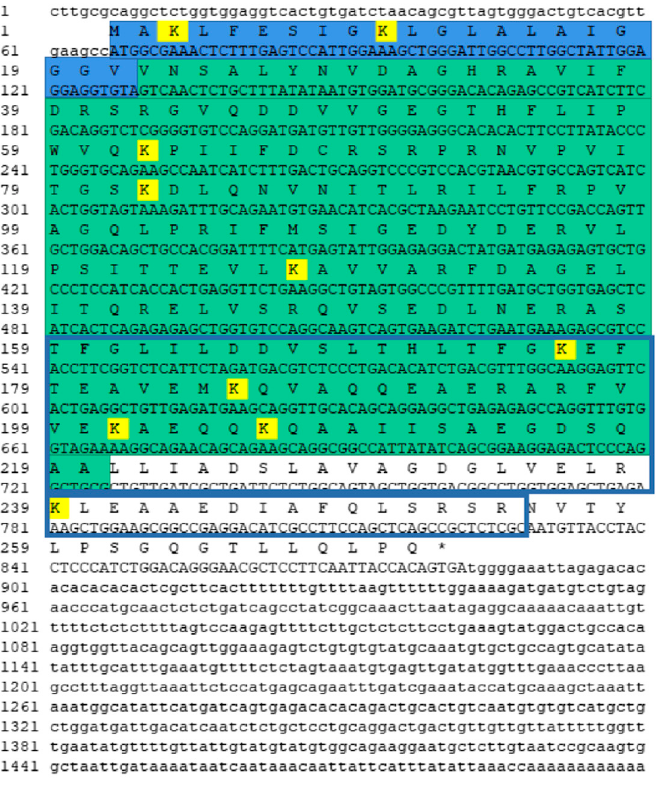
Figure 3. Full-length cDNA of Ob-phb and its amino acid sequence. The 5’ and 3’ UTR are marked with lowercase letters. Blue represents the transmembrane domain of the PHB protein, green represents the SPFH domain, and the blue rectangular area shows the predicted coiled-coil domain. Yellow indicates the conserved lysine sites in the PHB protein.